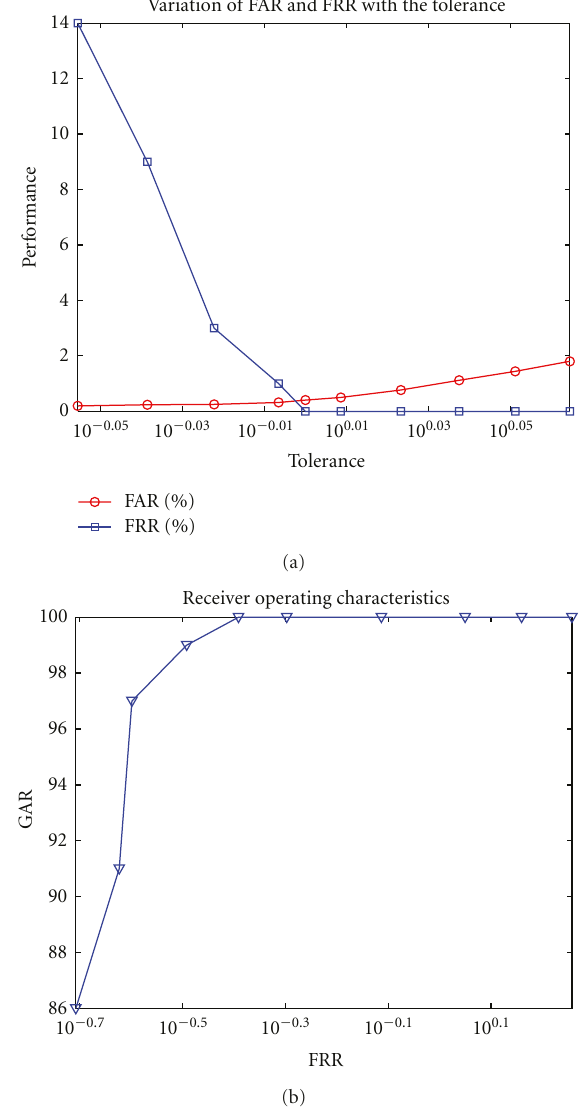
Figure 5: (a) The variations of the FAR and FRR characteristics with the tolerance for the palmprint-based cryptosystem, and (b) corresponding receiver operating